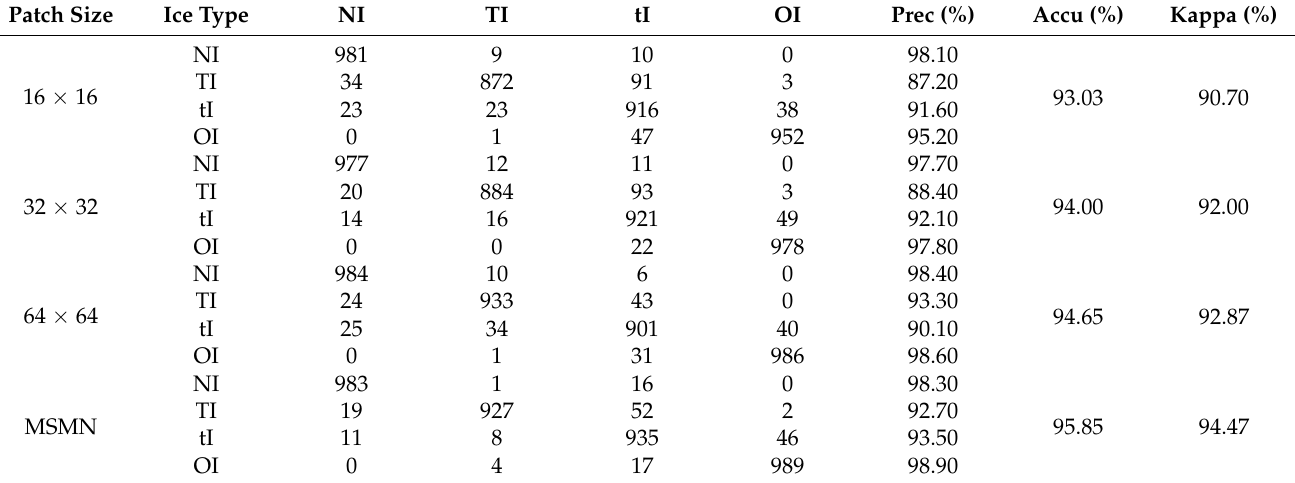
Table 4. Confusion matrix of classification results using different patch sizes and